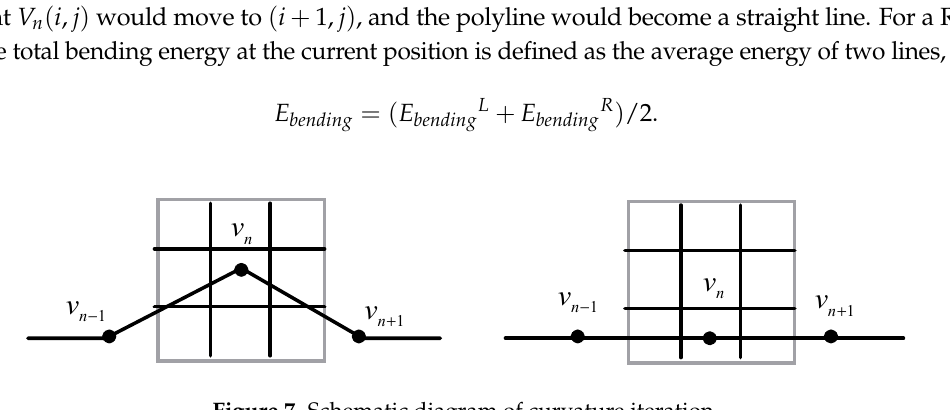
Figure 7. Schematic diagram of curvature iteration.